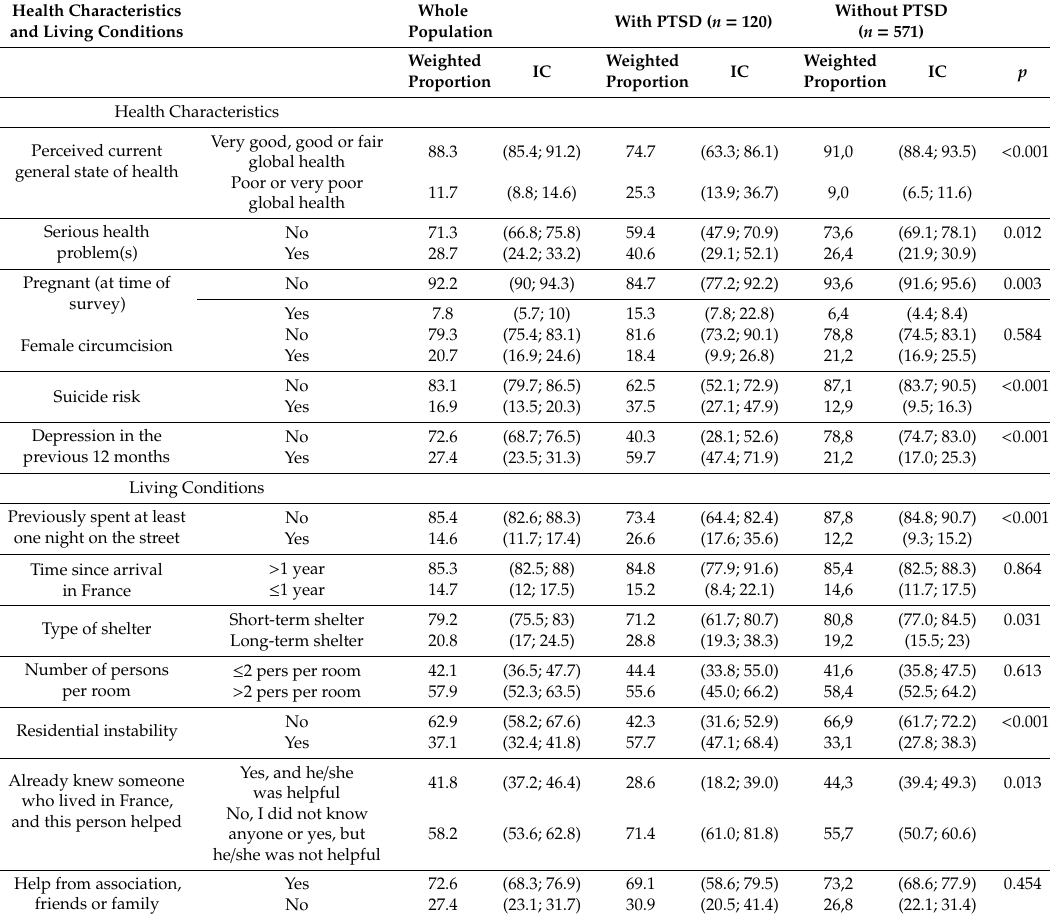
Table 3. Health characteristics and living conditions of homeless migrant mothers in the Paris region (ENFAMS survey 2013, n =